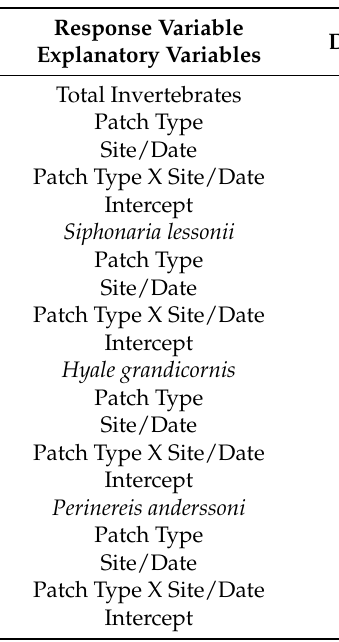
Table 7. Analyses of deviance for generalized linear models relating invertebrate counts (total invertebrates and three common species) with Patch Type ( Porphyra -covered vs. Exposed) and experimental Sites/Dates (Punta Cantera/2016, Los Acantilados/2018, Copacabana/2018, and Punta Hermengo/2016). Models were fit using a negative binomial distribution and a log link function. Significant deviance values (Chi-squared test, p < 0.05, see asterisks) indicate lack of effect of explanatory variables or their interaction on the dependent variable. D 2 is the proportion between the deviance explained by the model in question and the deviance of the null, intercept